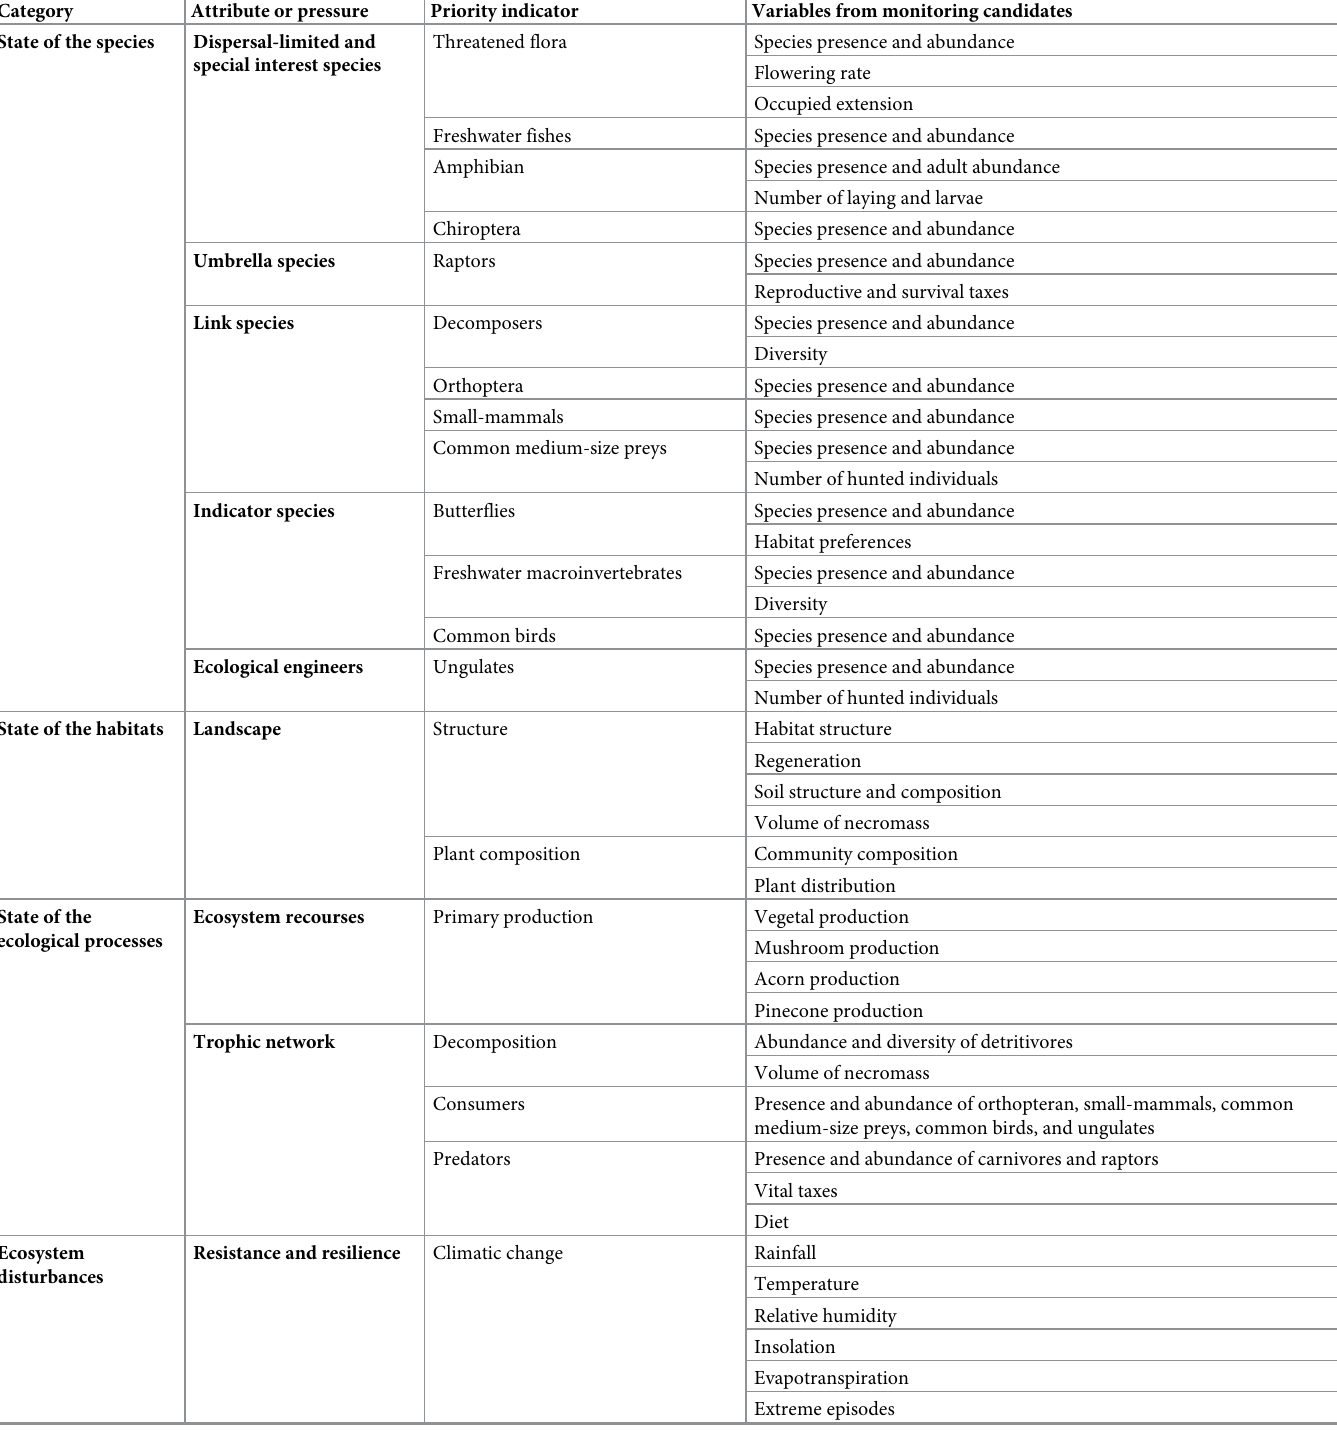
Table 5. Priority indicators (n = 27) that quantitatively meet selection criteria on Sant Llorenc¸ el Munt i l’Obac Natural Park. The indicators are divided into four categories and in different attributes or pressures [1], consequently, each require different variables from monitoring